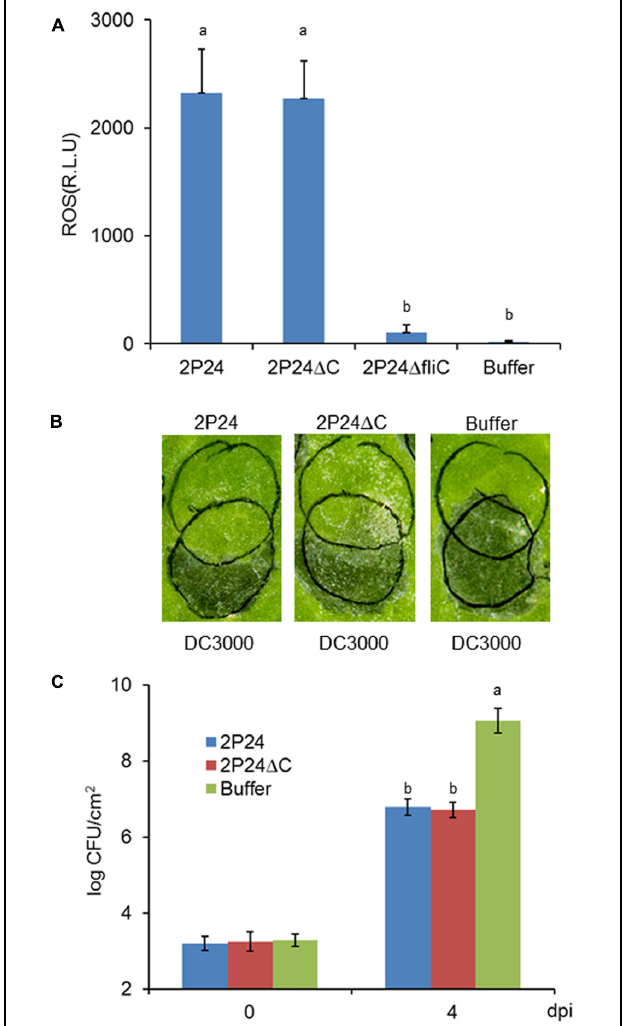
FIGURE 6 | P. fluorescens 2P24 and the rscC mutant have same strong functional MTI in N. benthamiana as determined by multiple assays. (A) ROS assay of strain 2P24 and the rscC mutant. The bacteria were infiltrated at 10 8 cfu/ml into N. benthamiana leaves and 15 h later assayed for ROS production using L-102 chemiluminescence. ROS assay results are presented as the mean and SD based on three samples from three different plants. Means shown with the same letters are not different statistically at the 5% confidence level on the basis of Duncan’s multiple range test. (B) Challenge inoculum HR assays for functional MTI. Strain 2P24 and the rscC mutant were initiated by infiltrating N. benthamiana leaves with 10 8 cfu/ml (upper circles). After 6 h, an overlapping inoculation of 10 7 cfu/ml of the HR-inducing strain P. syringae pv. tomato DC3000 (lower circles) was made. The presence or absence of confluent cell death in the overlapping region was evaluated 48 h after strain DC3000 infiltration. (C) In the assay for functional MTI based on relative growth of virulent bacteria, strain 2P24 and the rscC mutant were infiltrated into N. benthamiana leaves at 10 8 cfu/ml and challenged 6 h later with an overlapping inoculation of DC3000 (cid:2) hopQ1 at 10 5 cfu/ml. At the indicated days after the challenge inoculation (dpi), 0.5 cm leaf disks were collected from areas of overlap between pre-treatment and challenge inoculations and bacterial populations were determined by dilution plating. Bacterial populations from three independent leaves were assayed in triplicate. Means shown with the same letters are not different statistically at the 5% confidence level on the basis of Duncan’s multiple range